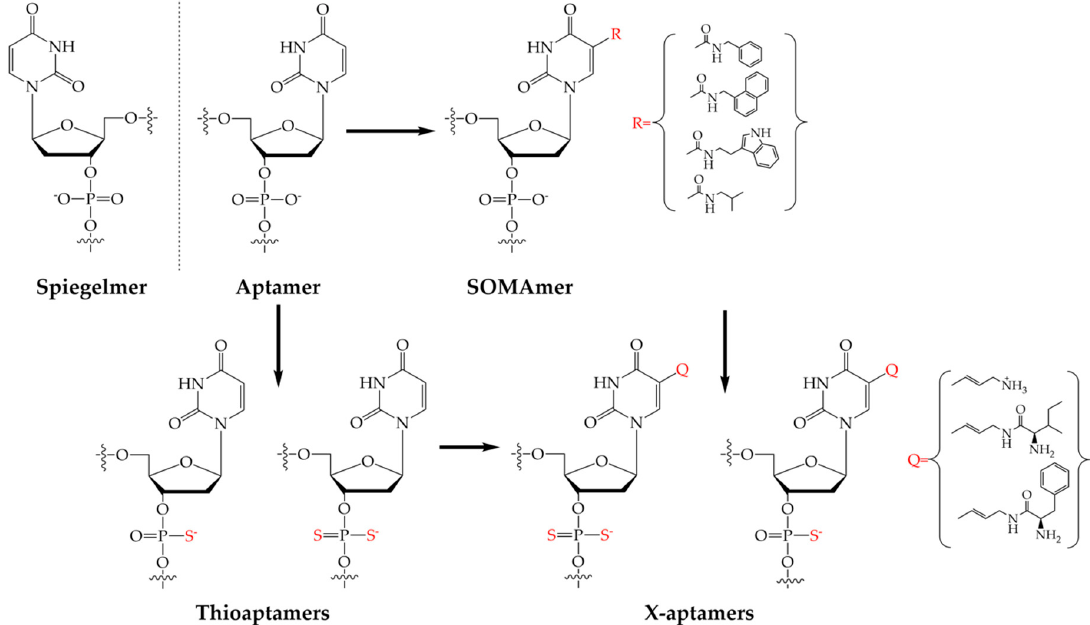
Figure 2. The most widely used modified aptamer derivatives: Spiegelmers, SOMAmers, Thioaptamers and X-aptamers. R and Q are referring to ligands that can be coupled to the bases to increase the affinity of the aptamer for the target.